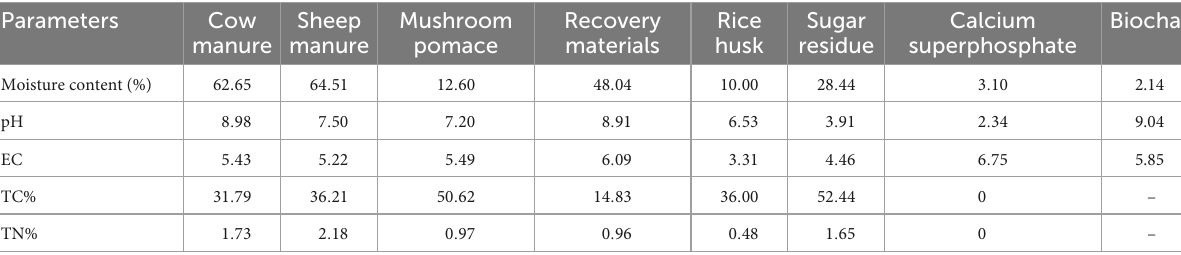
TABLE 1 The physicochemical properties of raw materials.